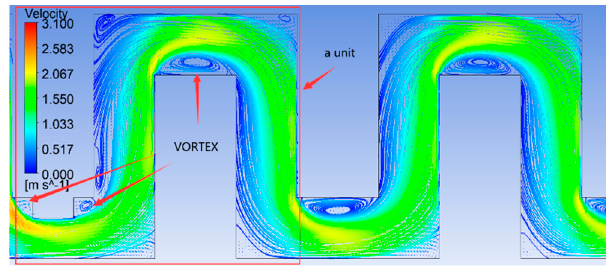
Figure 8. Streamlined diagram of the B emitters. ( a ) Streamlined diagram of the B 1 emitter; ( b ) Scheme 2 emitter; ( c ) streamlined diagram of the B 3 emitter.